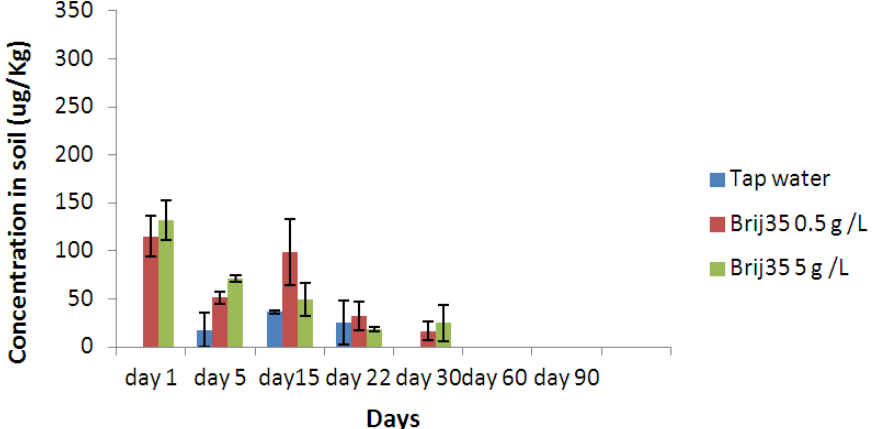
Figure 6. Metribuzin concentrations at 0.3 m